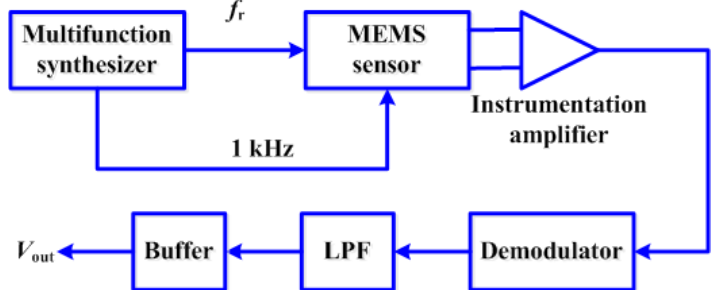
Figure 3. Signal conditioning stages of the MEMS magnetic field